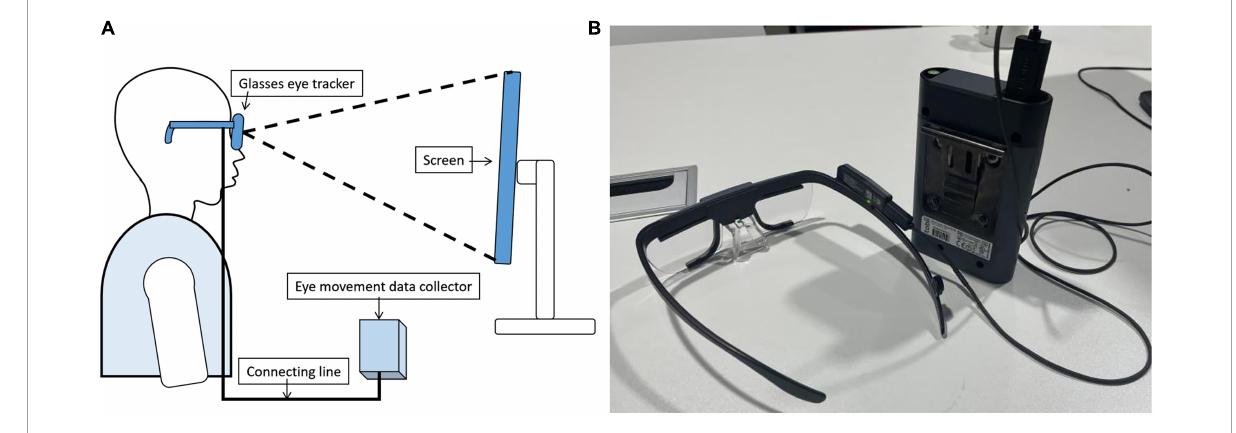
FIGURE4 Schematic diagram of the experimental process and experimental equipment: (A) schematic diagram of the experimental process; (B) experimental equipment (brand name of the equipment: Tobii Pro Glasses Eye